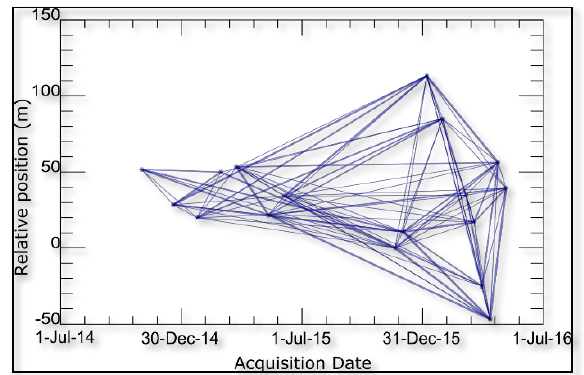
Figure 3. Spatial and temporal distribution of the Sentinel-1A dataset. Vertices represents SLC images. The edges in the graph denotes the formed interferograms. Baseline information can be acquired from Y